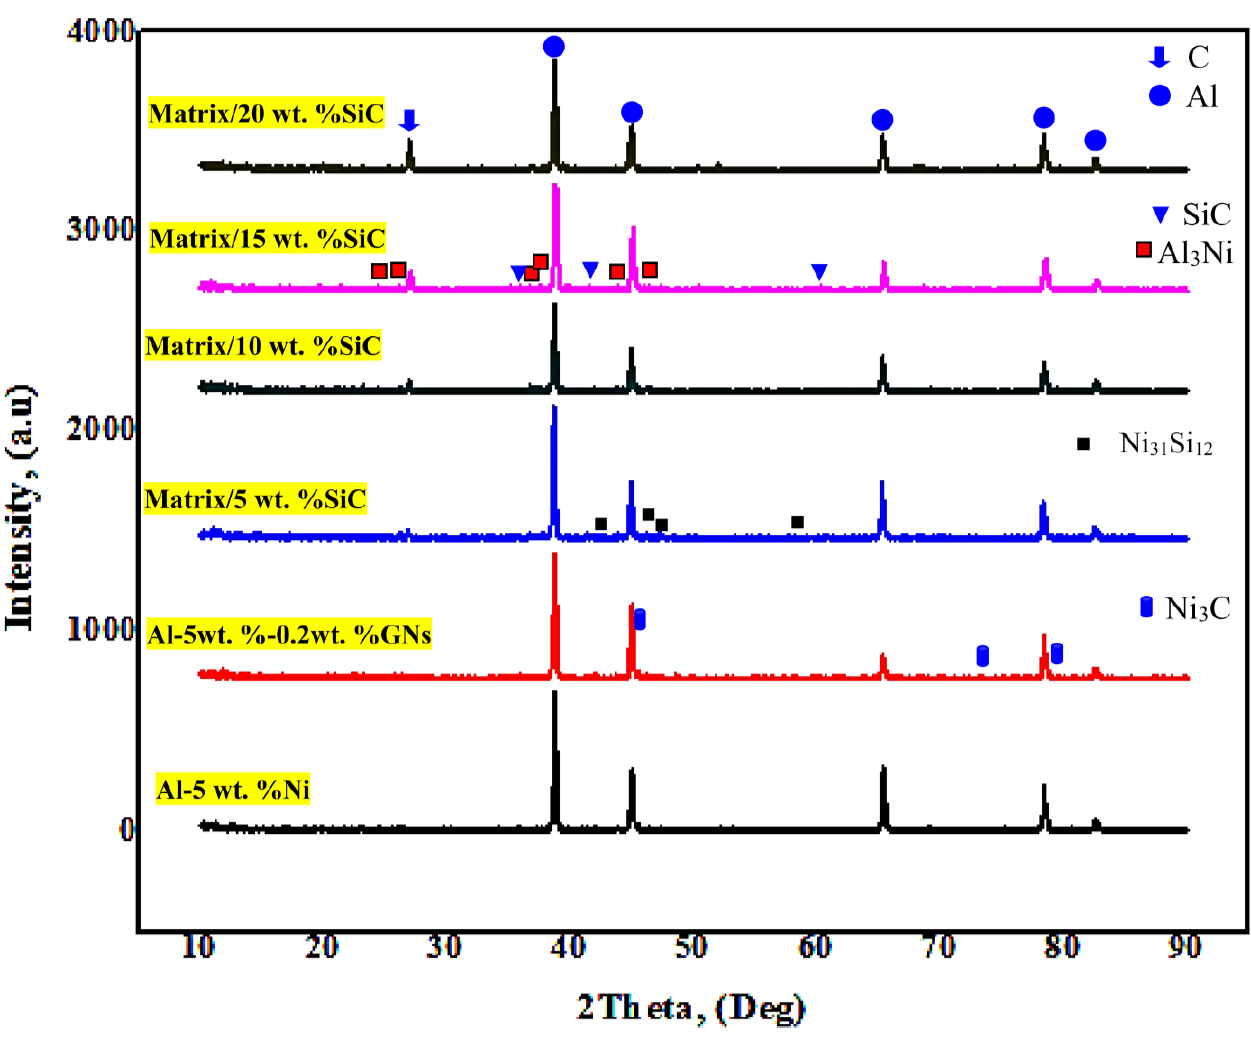
Figure 2. XRD patterns of consolidated samples at 600 °C.